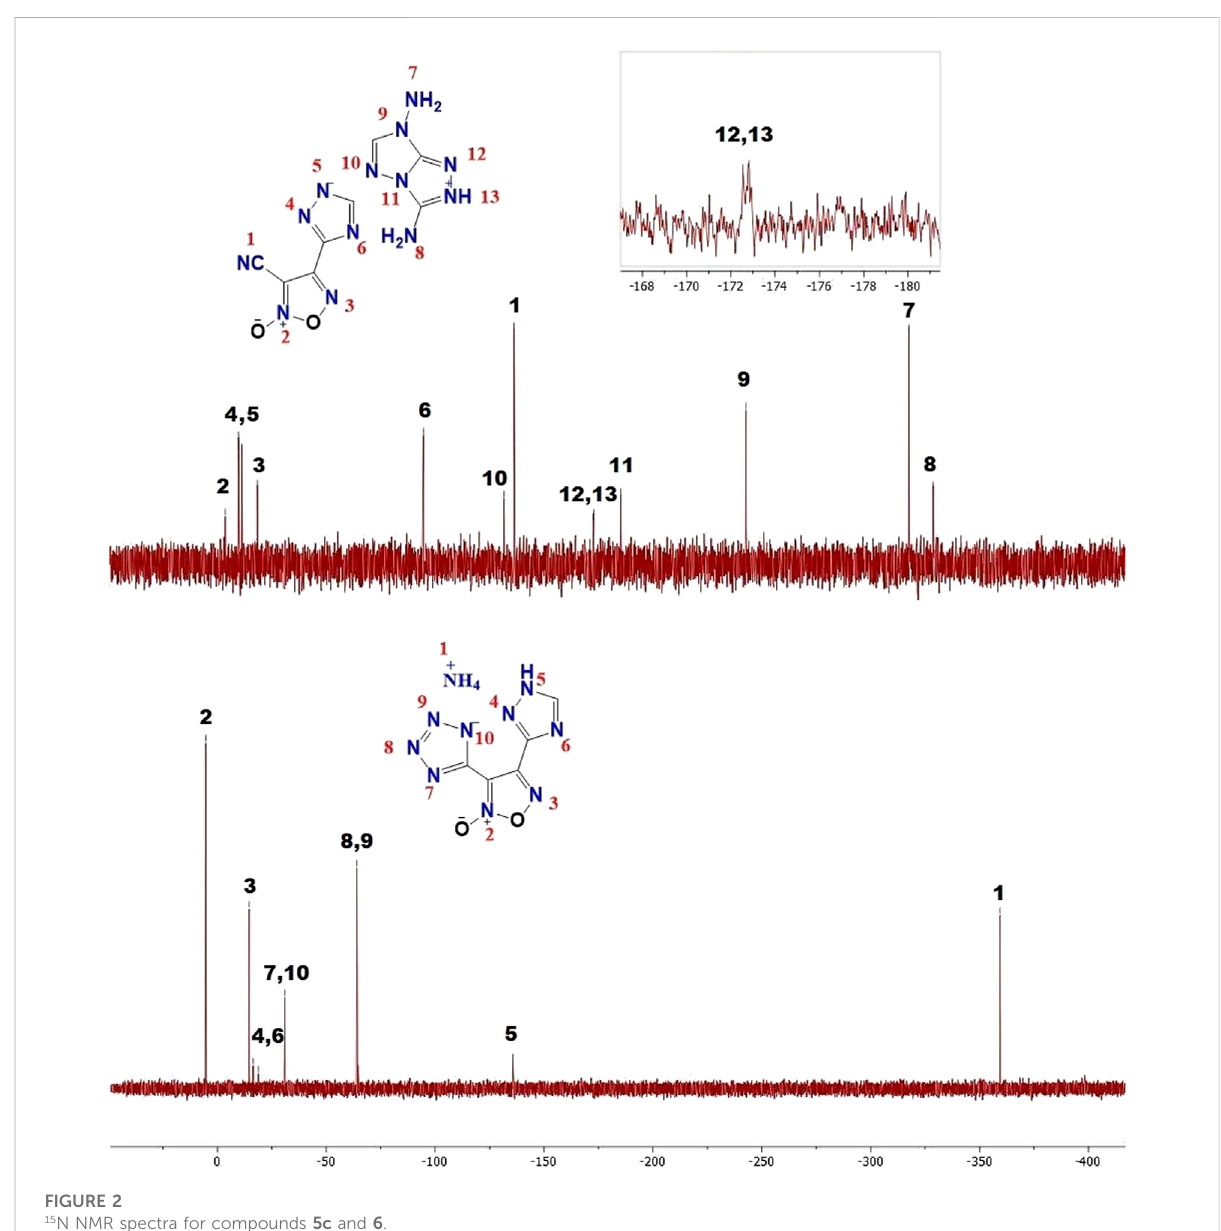
FIGURE 2 15 N NMR spectra for compounds 5c and 6